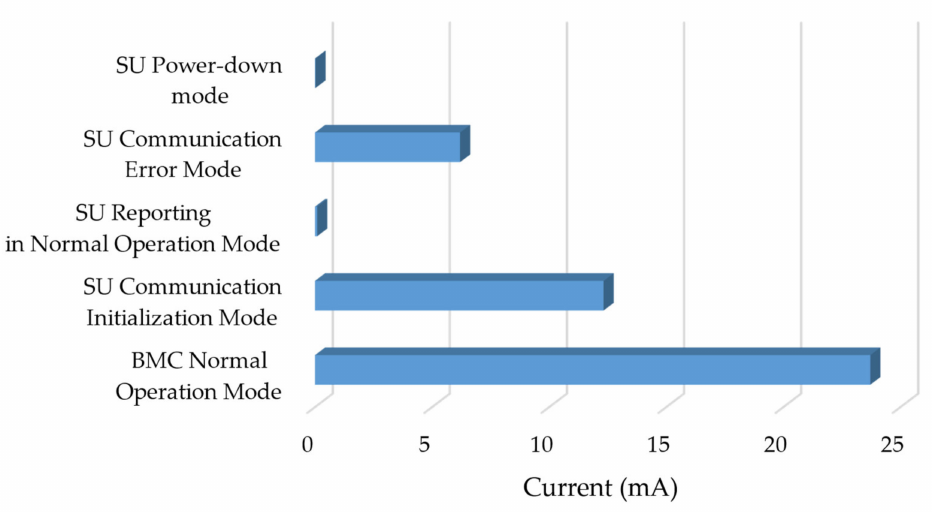
Figure 15. Comparative data of the MBMS supply current in all analyzed operating